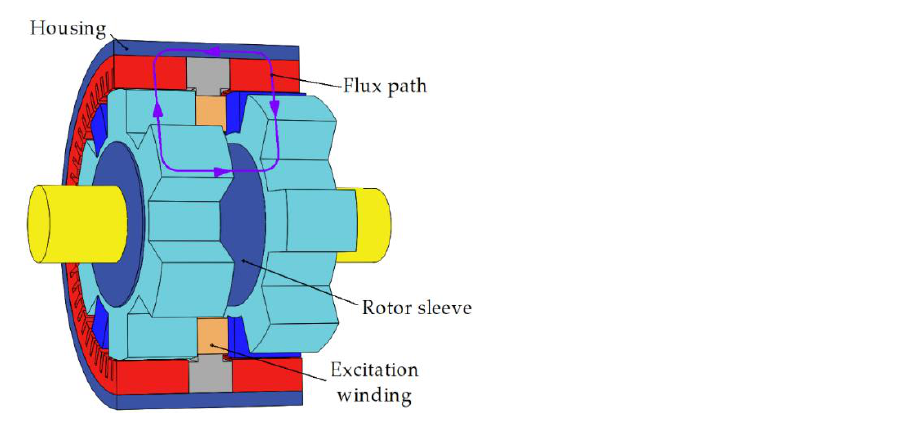
Figure 3. Excitation winding flux path through the stator housing, the SRCSs, and the rotor